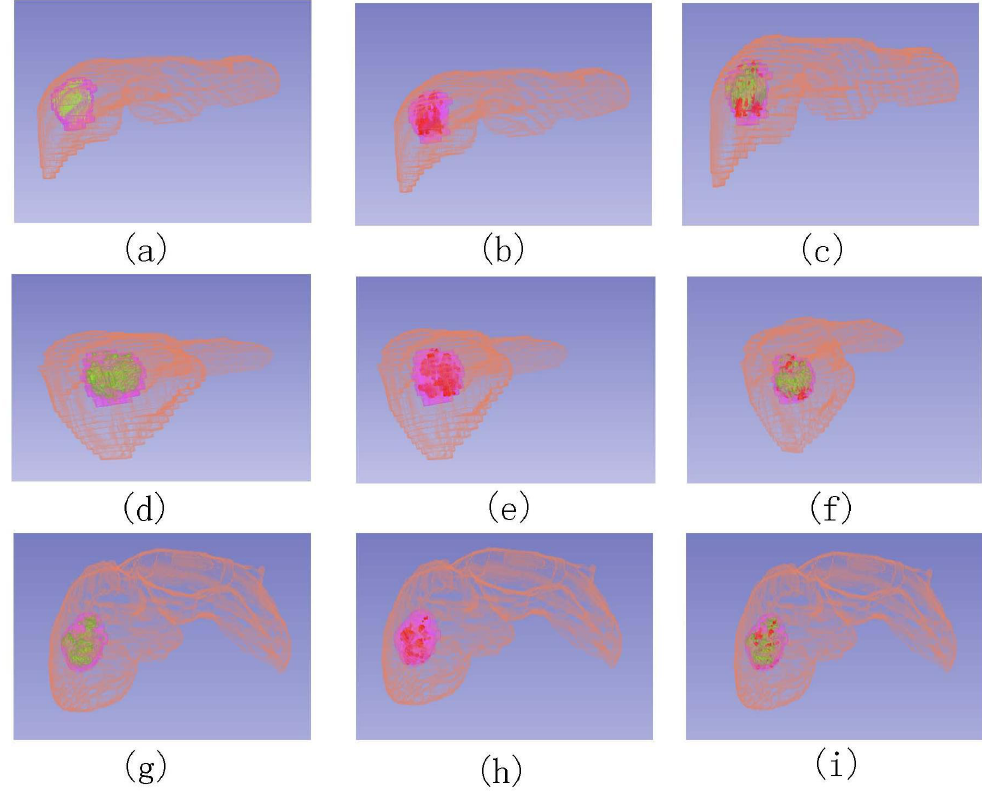
Figure 7. Locations of three different view: ( a , d , g ) show the APHE location (green), ( b , e , h ) show WO location (red), and ( c , f , i ) show the locations together. The purple area is the lesion delineated by